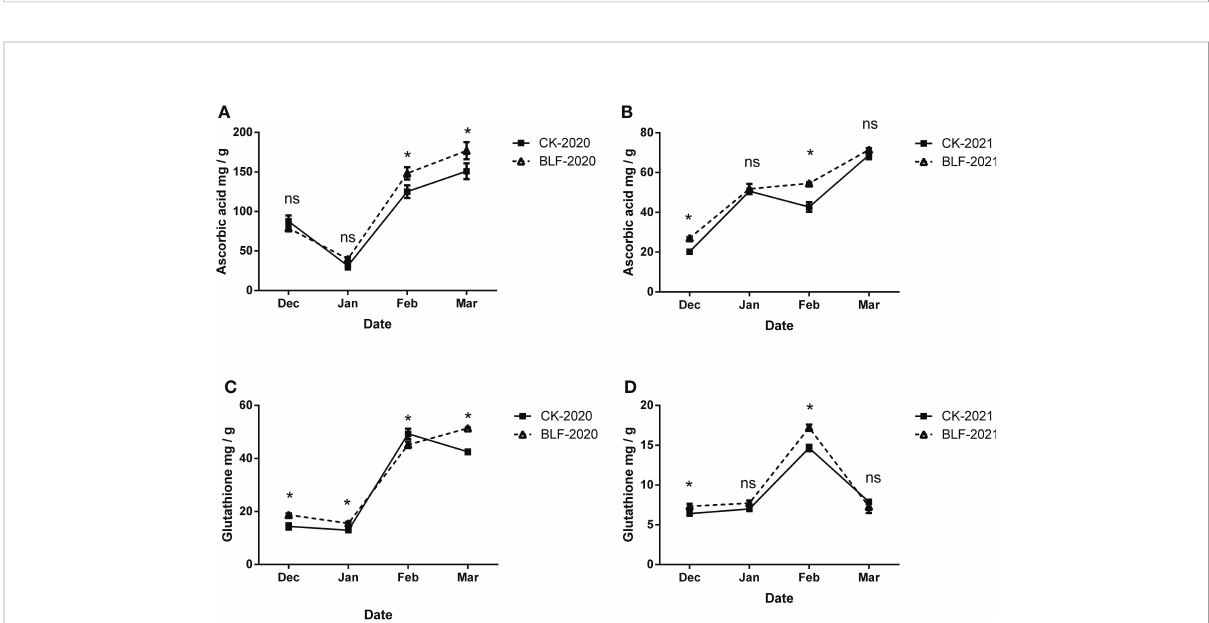
FIGURE 5 Effect of spraying BLF on the content of ascorbic acid (A, B) and glutathione (C, D) on 2020 and 2021. “ * ” means that the average value of each parameter is signi fi cant between the two treatments (p<0.05), and ns means no signi fi cance by Duncan ’ s multiple range